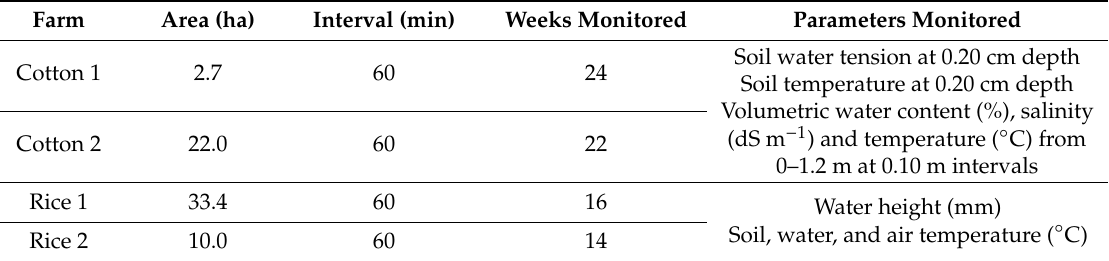
Figure 3. Pictures of a datalogger ( a ), multisensor capacitance probes installed in a cotton and rice farm ( b , c ), Watermark sensors ( d ), a Wi-Fi access point ( e ), and an IoT irrigation control autowinch ( f ).